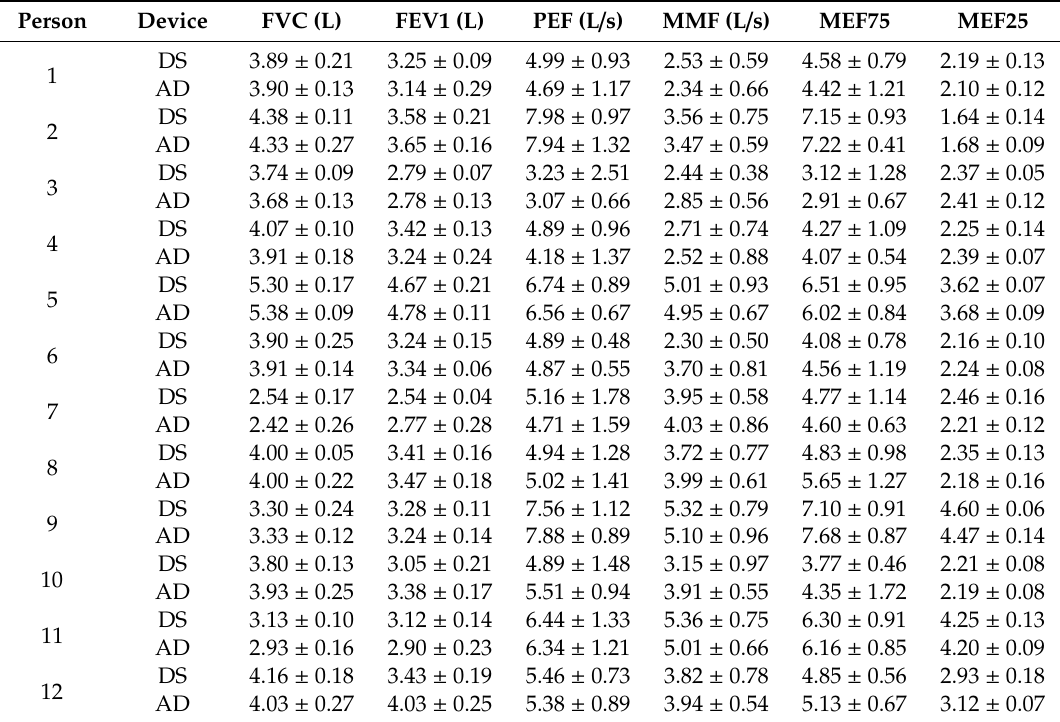
Table 2. Test results of 12 subjects with two